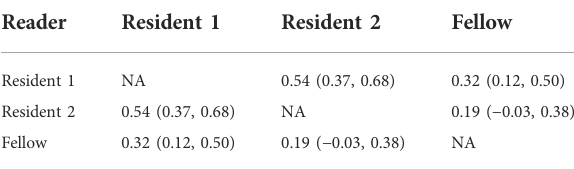
TABLE 3 Intraclass correlation coef fi cients (ICC) for Interobserver Agreement between the Clinical Readers in Localization of ACL Ruptures.